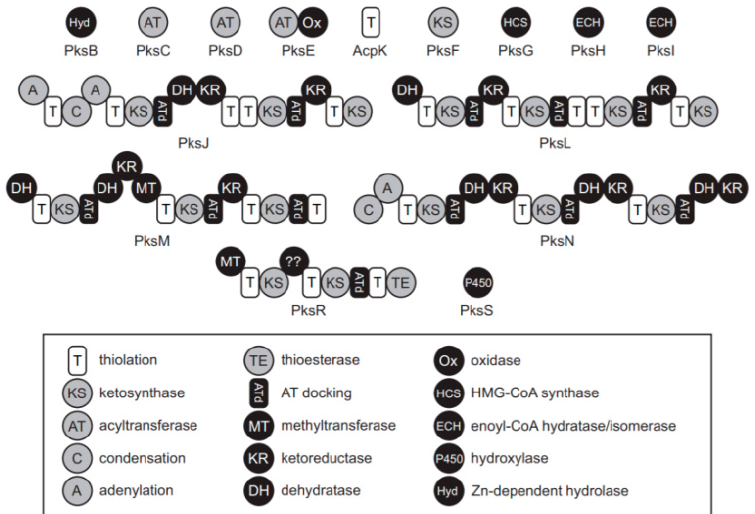
Figure 1. Conserved PKs proteins and functions in Bacillus modified from Straight et al. [37].